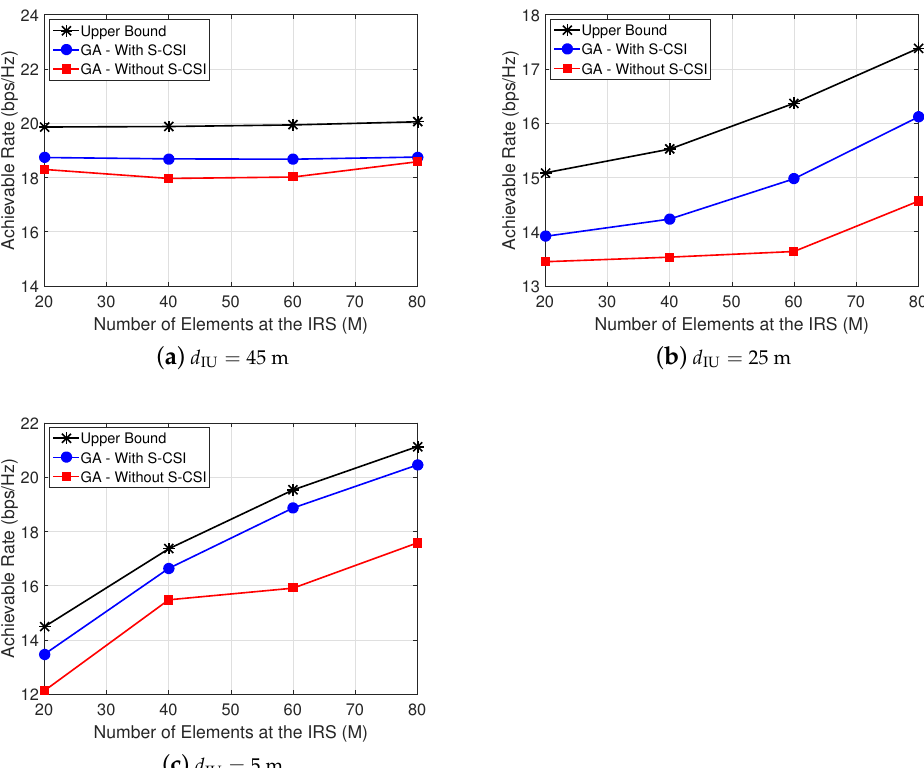
Figure 7. Achievable rate at UE versus the number of reflecting elements ( M ) at